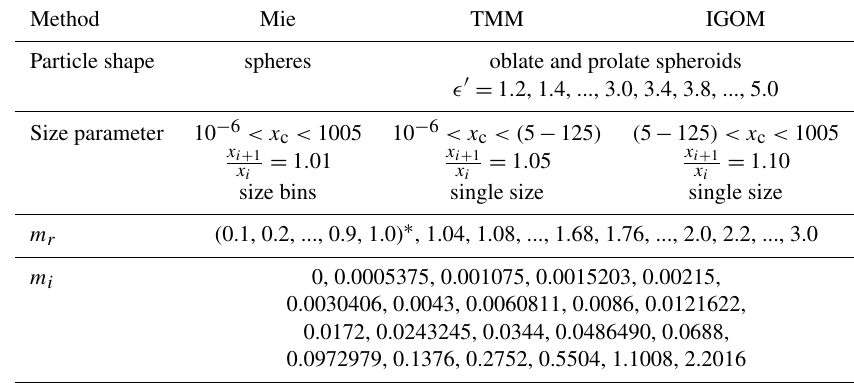
Table 1. Microphysics of spheres and spheroids considered in the MOPSMAP data set.